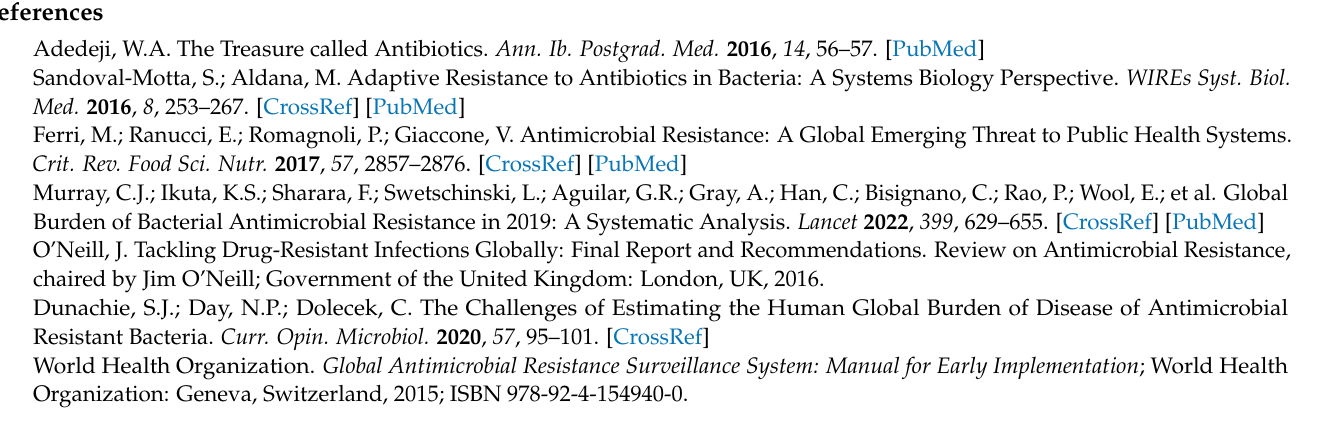
Figure S2: Co-occurrence relationships between predictive antimicrobial resistance genes (piARGs), Supplementary Figure S3: Co-occurrence relationships between microbes, Supplementary Figure S4: Hurlbert’s BN to two environmental properties Age and BMI, Supplementary Figure S5: Differentially abundant Subset of taxa at phylum, class, and order level, Supplementary Figure S6: Differentially abundant Subset of taxa at Family level, Supplementary Figure S7: Differentially abundant Subset of taxa at Genus level and Supplementary Table S2: Complete list of predictive antimicrobial resis- tance genes (piARGs) from https://www.genome.jp/kegg/annotation/br01600.html, denoted as ‘Signature KOs for antimicrobial